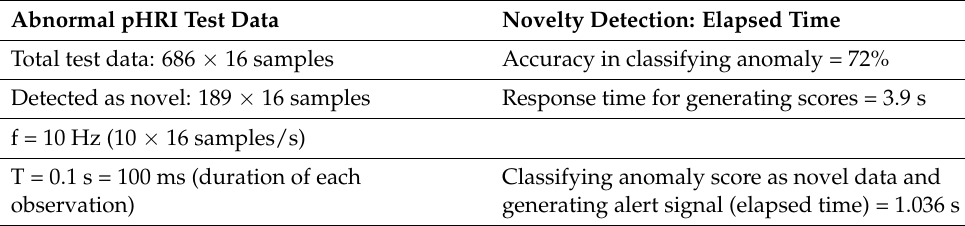
Classifying anomaly score as novel data and